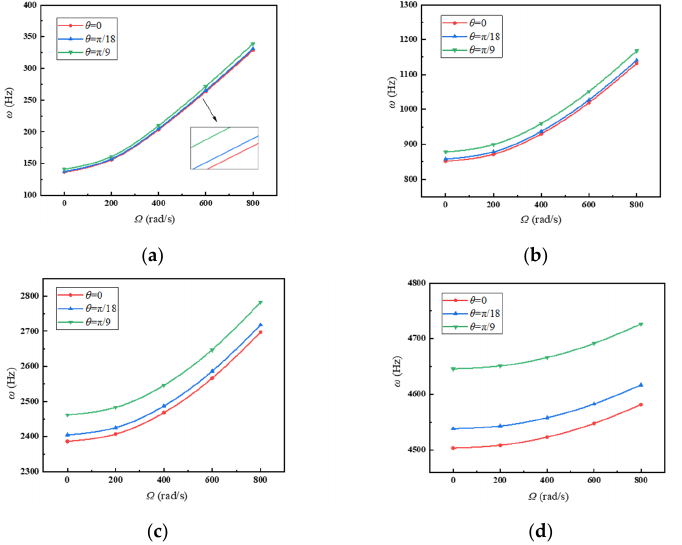
Figure 14. Variations of frequencies with rotating speed under different setting angles. ( a ) First frequency; ( b ) second frequency; ( c ) third frequency; ( d ) fourth frequency.